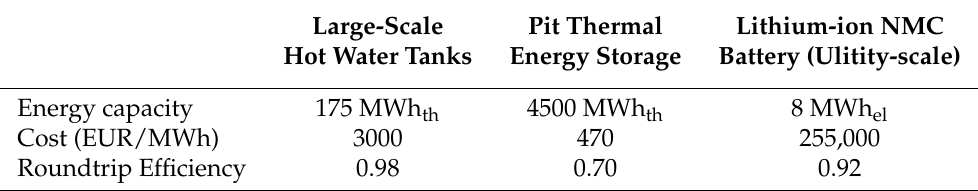
Table 1. Cost of energy storage in 2050 according to